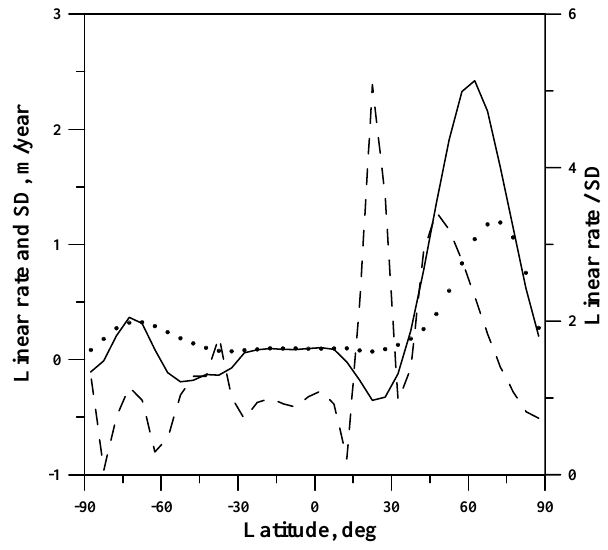
Fig. 10. The estimated linear rate (solid line), its standard devia- tion (dotted line), and absolute value of their relation (dashed line), for the amplitude of SPW1 in the geopotential height at the 30hPa